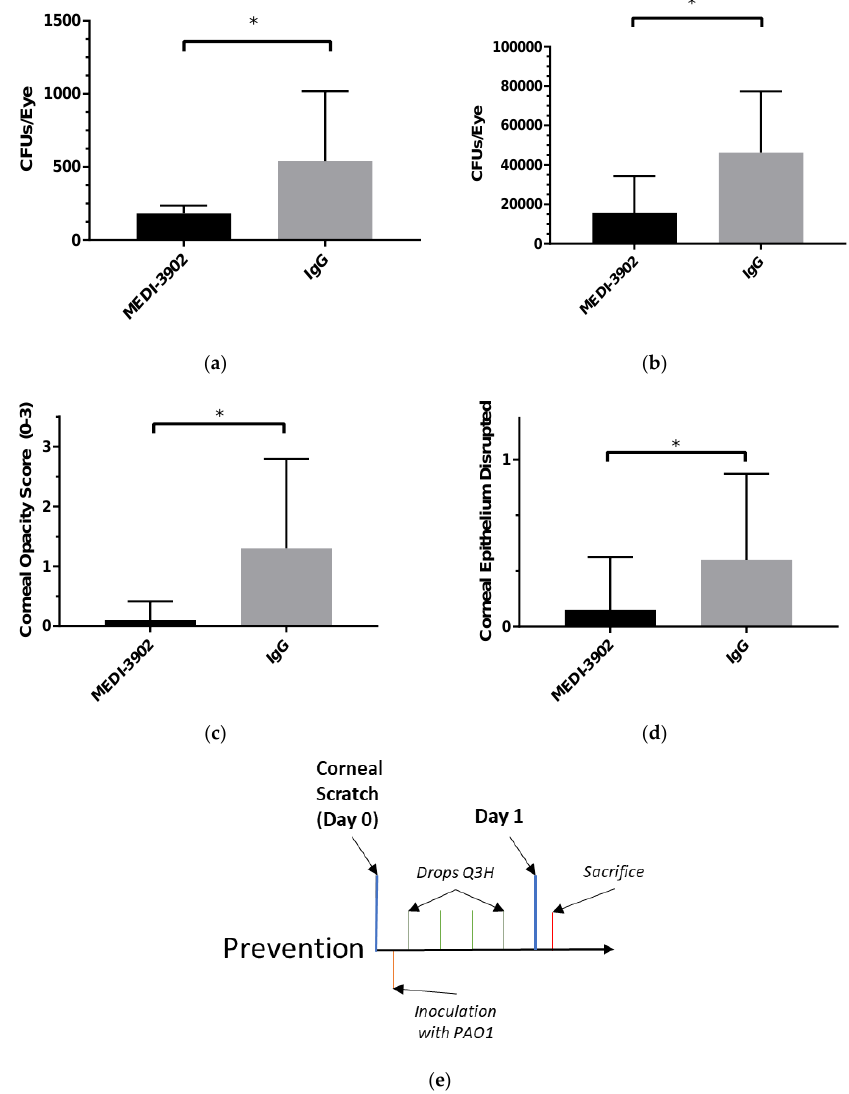
Figure 2. MEDI3902 can prevent an infection of Pseudomonas aeruginosa (PAO1) keratitis from occurring when given at the time of inoculation: Mice were challenged with both a low inoculum (~5 × 10 5 ) ( a , c , d ) and a high inoculum (~5 × 10 7 ) ( b ) of PAO1 following corneal scratch and then subsequently treated with IgG ( n = 10) or MEDI3902 ( n = 10). Mice treated with MEDI3902 had fewer CFUs retrieved one day status post inoculation ( a , b ), decreased corneal opacity ( c ), and fewer disrupted epithelia ( d ) versus their IgG counterparts. (Mean ± SEM) MEDI3902 treated low = 183.6 ± 16.6; IgG treated low = 539.3 ± 151.4; MEDI3902 treated high = 15,620 ± 5918; IgG treated high = 46,330 ± 9818; Opacity score: MEDI3902 low 0.1 ± 0.1; IgG low 1.3 ± 0.5. Epithelial score: MEDI3902 low 0.1 ± 0.1; IgG low 0.4 ± 0.2. Epithelial and opacity scores for high not shown. ( a ) Low inoculum; ( b ) high inoculum; ( c ) low inoculum; ( d ) low inoculum; ( e ) timescale.